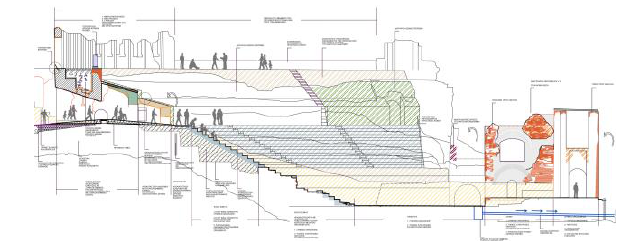
Figure 3. Theatre of Nikopolis. Section, current state of the theatre.